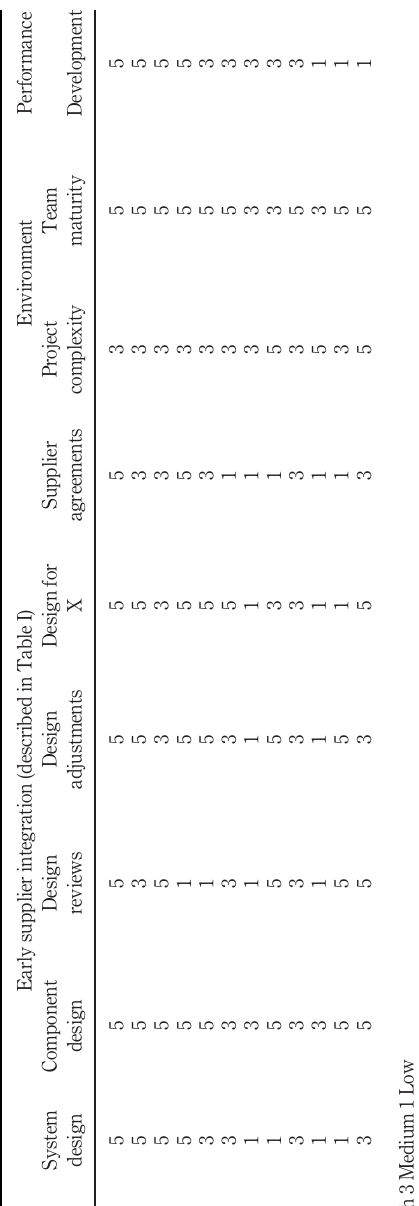
Table III. Supplier involvement levels, environment and development